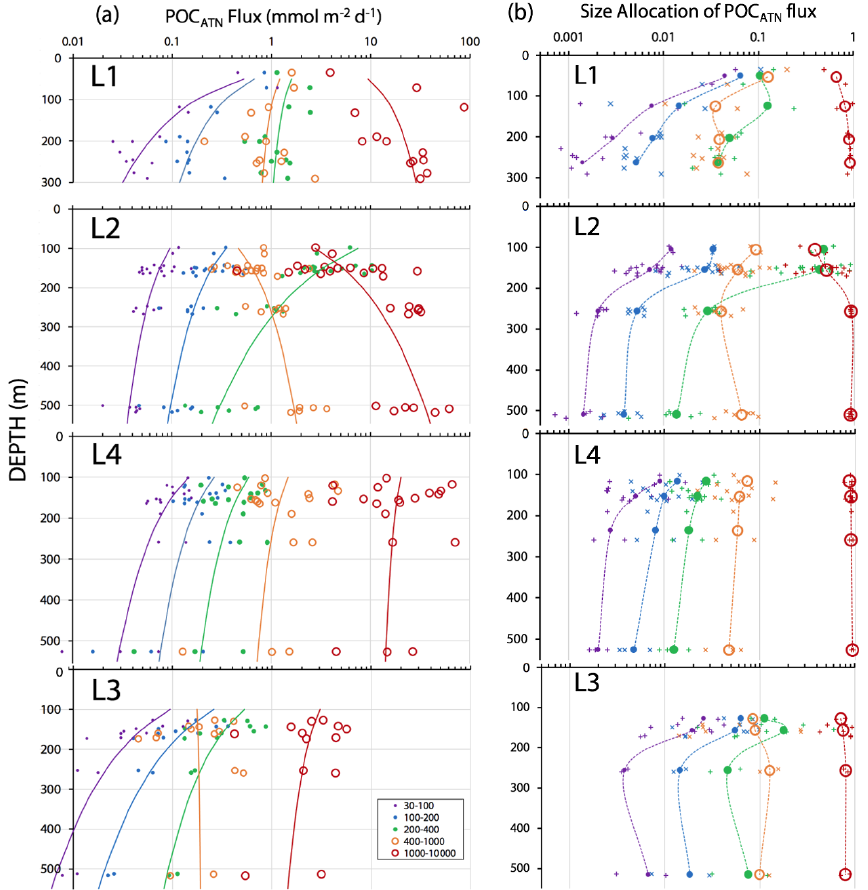
Figure 15. (a) POC ATN flux in mmolCm − 2 d − 1 partitioned in 30–100, 100–200, 200–400, 400–1000, and > 1000µm particle size classes for all CFE dives from in-filament locations L1, L2, and L4 and from transitional waters at L3. The curves denote Martin function fits to the data (Table 3). (b) Fraction of POC ATN flux allocated to 30–100, 100–200, 200–400, 400–1000, and > 1000µm size fractions. Large symbols connected by dashed curves are averages of pooled data, and small points correspond to individual dives. Aggregates greater than 1000µm in size dominated flux in all regimes with the exception of the 100m at